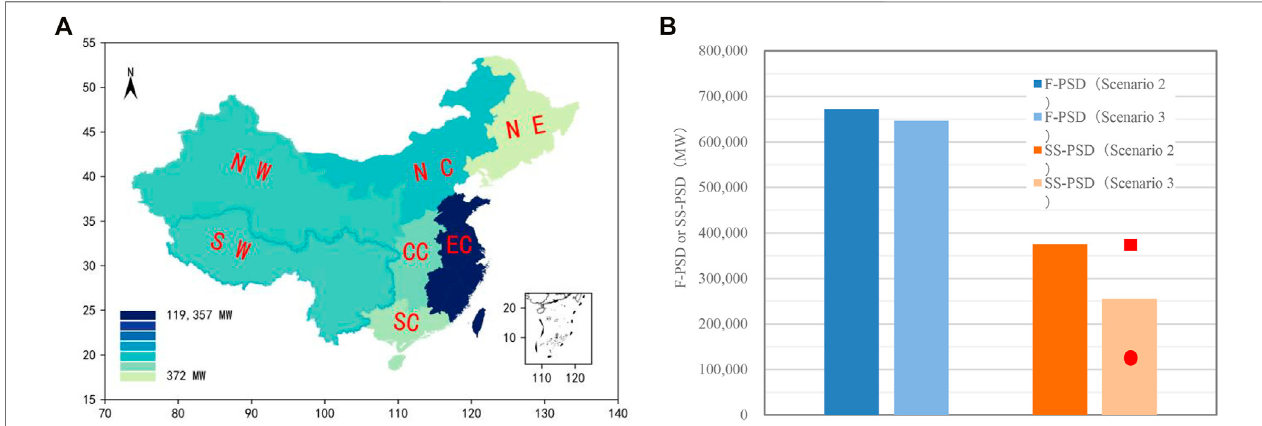
FIGURE 2 | Distribution of gas peak shaving capacity demand in areas in Scenario 3 (A) and National peak shaving demand (F-PSD) and capacity demand (SS- PSD) under Scenario 2 and 3 (B) . For the sake of simplicity, some islands are not drawn in the (A) . The darker color in the fi gure means the greater demand for peak shaving capacity in the area. In the (B) , the small red rectangles and circles represent the sensitivity analysis results of capacity demand on deep peak shaving capacity. The small rectangle represents the capacity demand (SS-PSD) when the deep peak shaving ability (D-PSA) decreases by 20% (Scenario 3). The small circle represents the SS-PSD when the D-PSA increases by 20% (Scenario